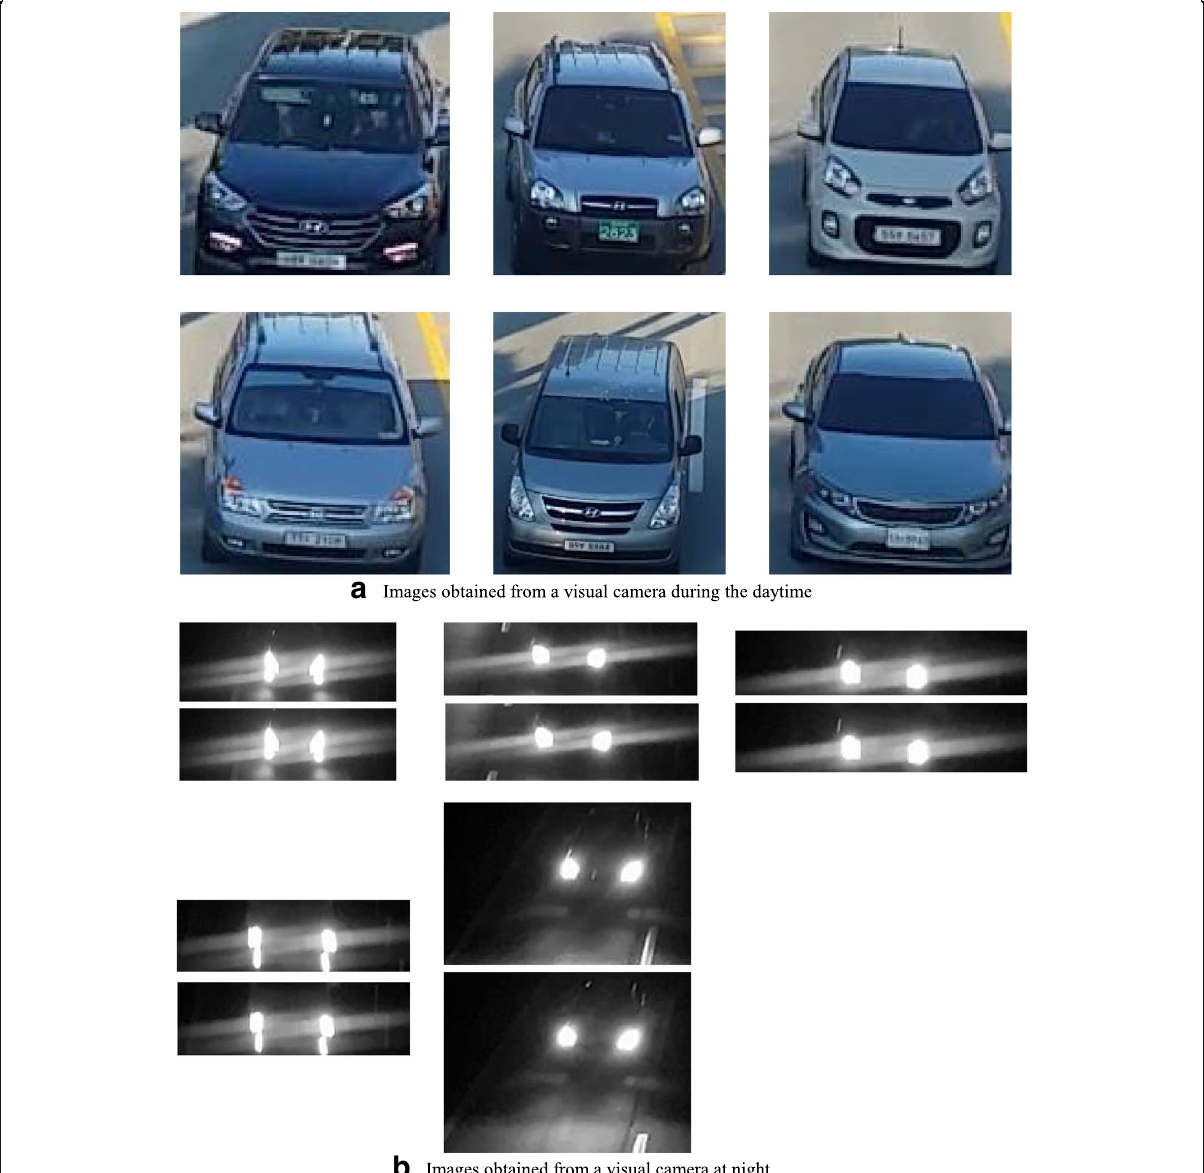
Fig. 6 Images obtained from a visual camera during the daytime and at night. a Images obtained from a visual camera during the daytime. b Images obtained from a visual camera at